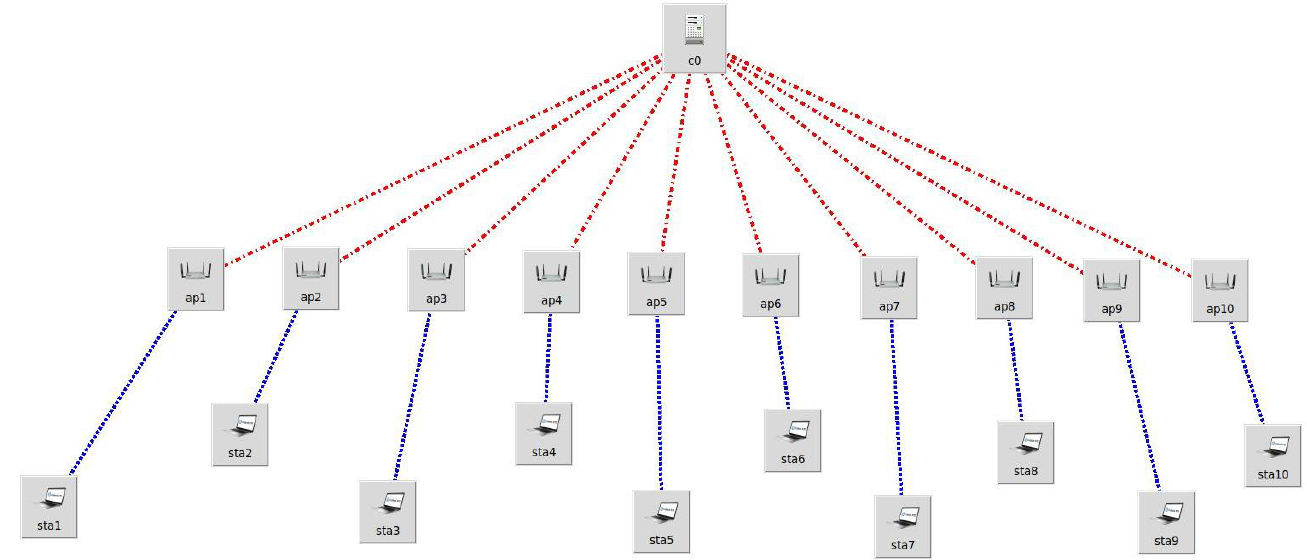
Figure 4. Mininet-Wi-Fi-created linear topology.